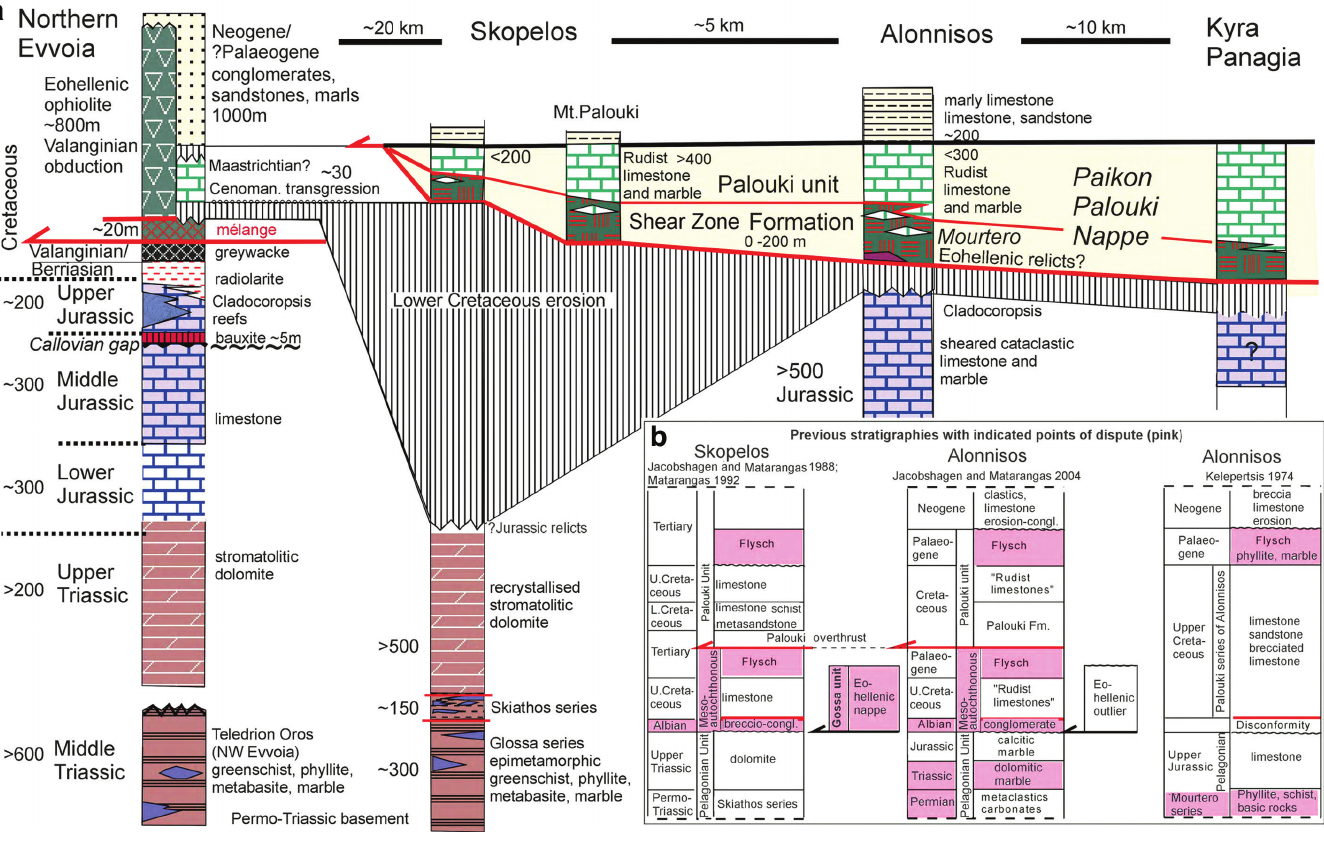
basement [21] and the dolomite sequence of Evvoia correlate well with the Glossa and skiathos Modified stratigraphy of alonnisos and series, as well as the Triassic dolomites of skopelos (Fig. 3a). In contrast, the Triassic is not skopelos islands compared to disputed exposed on alonnisos island, and has not been verified on Kyra Panagia or Megalo aderfi either. previous stratigraphic The Jurassic is, besides a few small enigmatic outcrops, absent from skopelos, whereas Jurassic constitutes the oldest exposures on alonnisos, where the reefal facies is similar to that of Evvoia (Fig. 3a). The stratigraphically oldest marbles observed on Kyra Panagia and Megalo aderfi occur below metabasites and are thought to be of Jurassic age, but no definite verification could be made. Widespread remnants of the Eohellenic ophiolitic thrust sheet (serpentinite, peridotite, basalt, radiolarite) exist on Evvoia, whereas the inferred ophiolite on the other islands of the study area had been eroded during the Cretaceous, and serpentinite could not be verified. a small in situ relict of Eohellenic metabasite is possibly preserved on alonnisos (see below). On Evvoia, transgressional conglomerate overlies ophiolite mélange and Tithonian–Berriasian radiolarian cherts [3, 22]. The conglomerate contains serpentinite and radiolarian chert-pebbles, and in turn is overlain by a 30-m limestone succession containing abundant rudist bivalves and foraminifera, which range in age from Coniacian to Maastrichtian [19]. In contrast to this, on the other islands of the study area, in situ Cretaceous sediments probably were never deposited (see Discussion below). Instead, the Cretaceous carbonates are allochthonous and overthrust a tectonically mixed brittle-ductile shear-zone (terminology after [23]), composed of a dynamically metamorphosed, oceanic mélange of sericitized basalt and radiolarian chert, which directly overlies the Pelagonian formations. Occurrences of laterite are widespread on skopelos [11], in contrast to alonnisos where laterite is not conspicuous. The re-deposited laterite occurs within joints and karstic fractures in the dolomite formation as well as in cataclastic rocks that can attain thicknesses of up to about 150 m. Primary in situ laterite could not be verified. The origin of the primary laterites may have been multi-temporal, considering that the entire eroded ophiolitic thrust sheet and underlying Jurassic carbonates had been their source. On Evvoia, laterite (Bauxite, Fig. 3a) was deposited during the Callovian as well as during the post-Eohellenic period [3, 24].